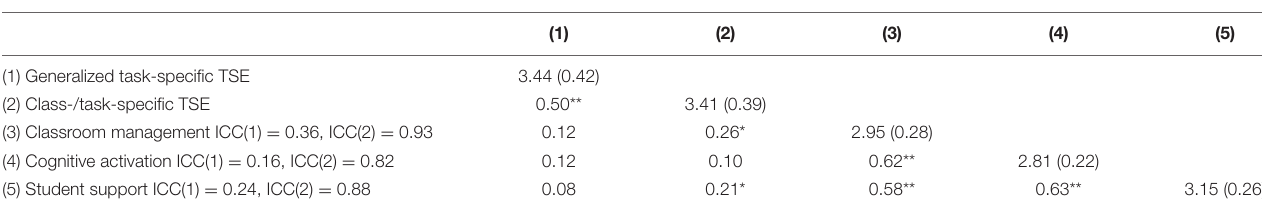
TABLE 1 | Descriptive statistics and intercorrelations of the study variables on level